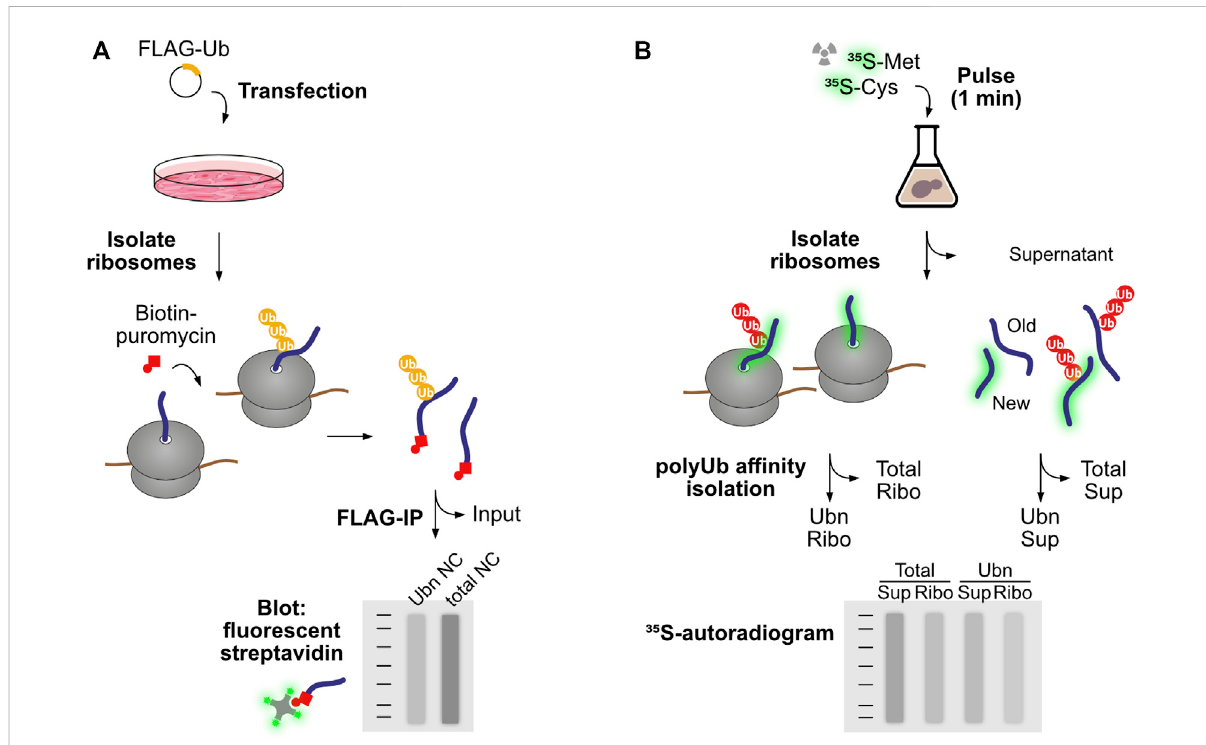
FIGURE 1 Experimental work fl ows to study co-translational ubiquitination. (A) Wang et al. introduced FLAG-tagged ubiquitin to human cells to enable puri fi cation of ubiquitinated protein species by FLAG immunoprecipitation. To restrict the analysis to nascent proteins, fi rst ribosomes were isolated and associated polypeptides were labeled and released from the ribosome using biotin-puromycin. Following separation of ubiquitinated and non- modi fi ed species, nascent chains were detected based on the binding of fl uorescent streptavidin with the biotin-puromycin label. (B) Duttler et al. pulse-labeled nascent proteins with 35 S-labeled amino acids for a short period of time (1 min). After this pulse, some labeled nascent proteins were still associated with ribosomes, while others reached termination and ribosome release. Ribosomes were then isolated from completed proteins and both fractions were submitted to polyubiquitin af fi nity isolation. Nascent chains and newly synthesized released proteins were then detected by autoradiography. The fraction of co-translational ubiquitination is calculated as the amount of 35 S-labeled nascent chains isolated by polyUb af fi nity over total 35 S-labeled nascent chains in the ribosomal